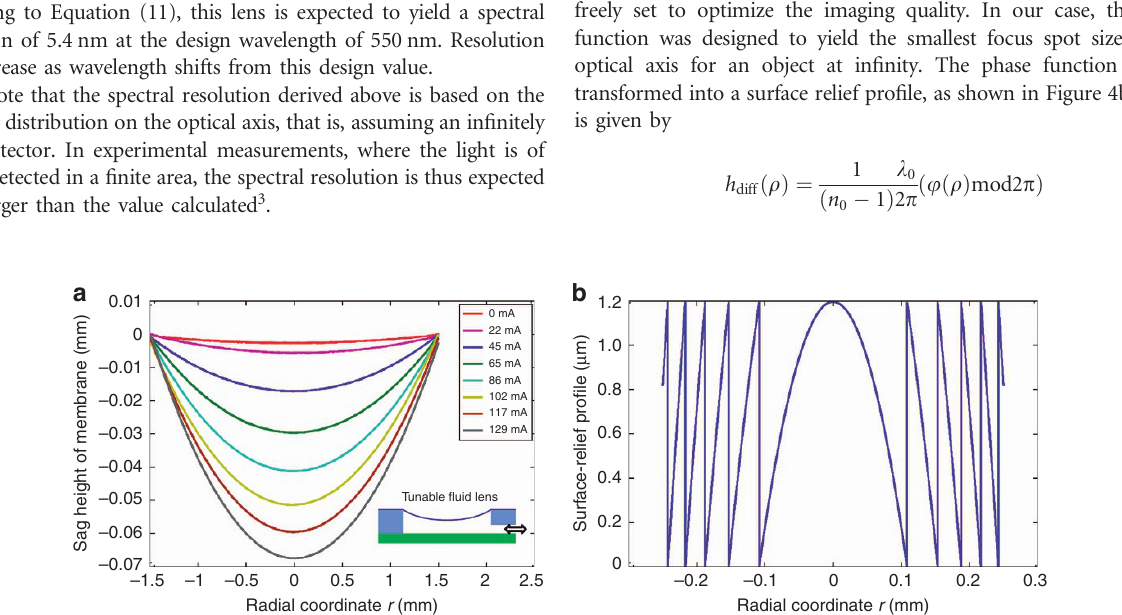
Figure 4 Lens pro fi les. ( a ) Measured concave refractive membrane pro fi les of the hydraulically tunable lens at different actuation settings, as measured by a stylus pro fi lometer; the current values are those of the magnetic actuator; ( b ) the calculated pro fi le of the diffractive Fresnel lens, calculated from the phase